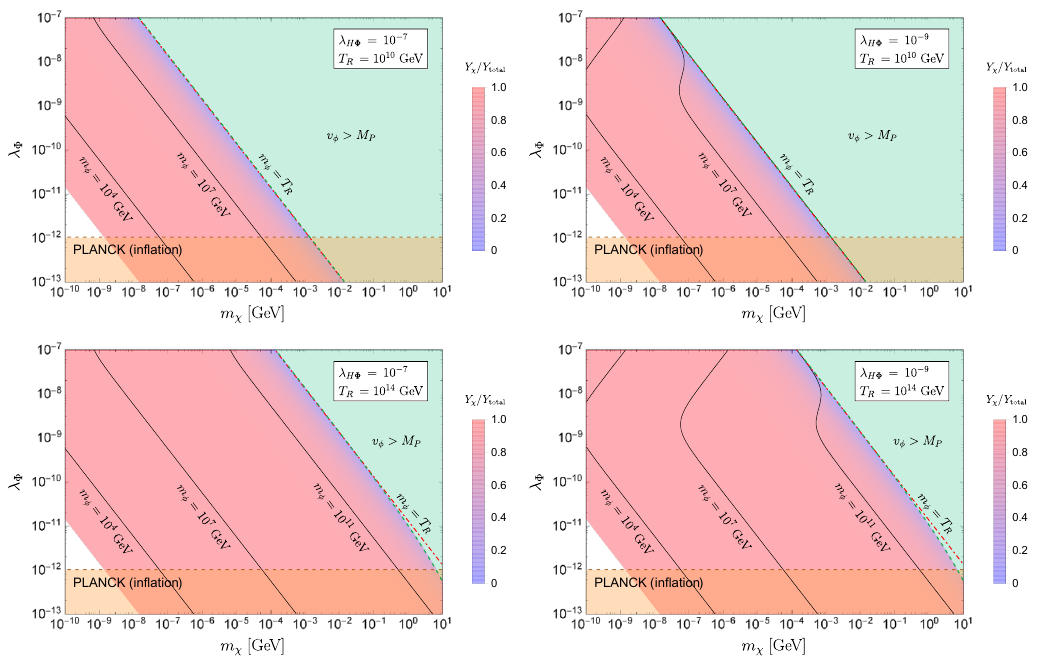
Figure 8 . Same plots as figure 7 while the reheating temperature is taken to be a free parameter. The portal coupling is chosen as λ = 10 − 7 (left) and 10 − 9 (right), and the reheating temperature H Φ is T = 10 10 GeV (above) and 10 14 GeV R